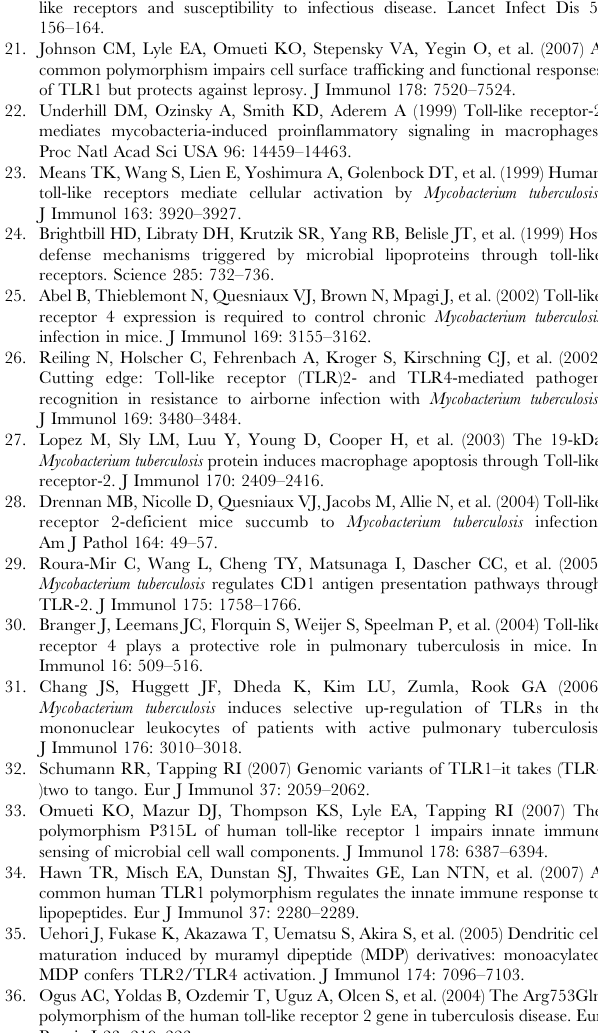
Table S4 Oligonucleotide primers used to amplify and sequence TLR1, 2, 4, 6, and